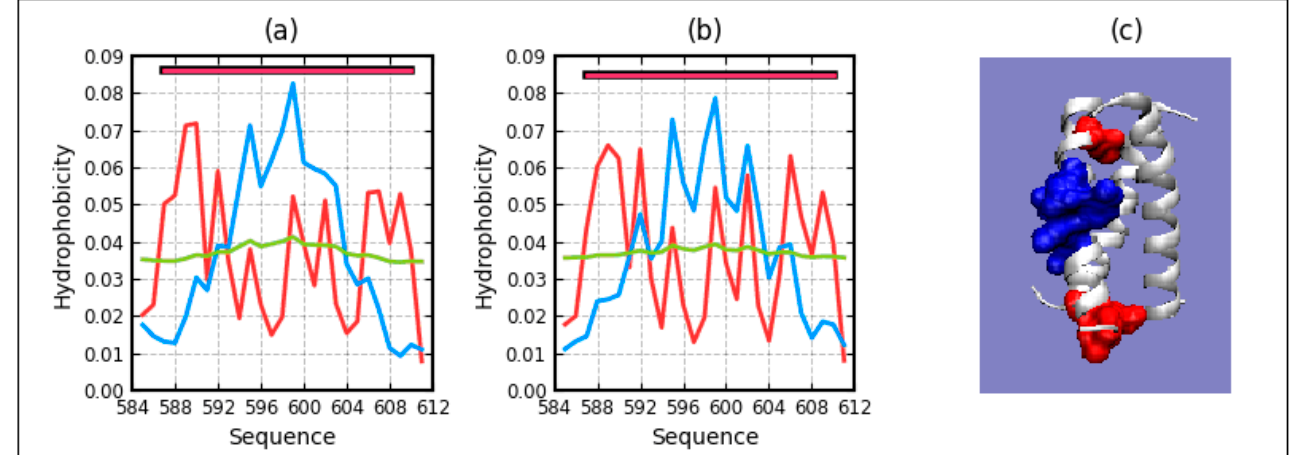
Figure 14. Potassium channel subunit alpha kvlqt1 Profile T (blue), O (red), M (green) ( a ) chain A as an individual structural unit, ( b ) chain A as part of complex, ( c ) 3D presentation of the complex with residues of hydrophobicity deficiency—red, of hydrophobicity excess—red. Colors are only shown for chain A.